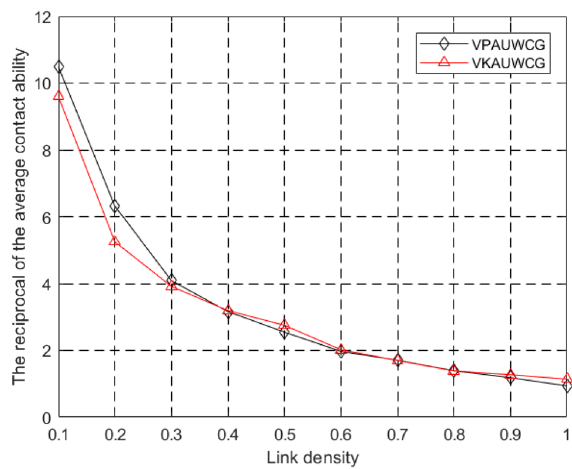
Figure 8. The reciprocal of the average contact ability of different link density